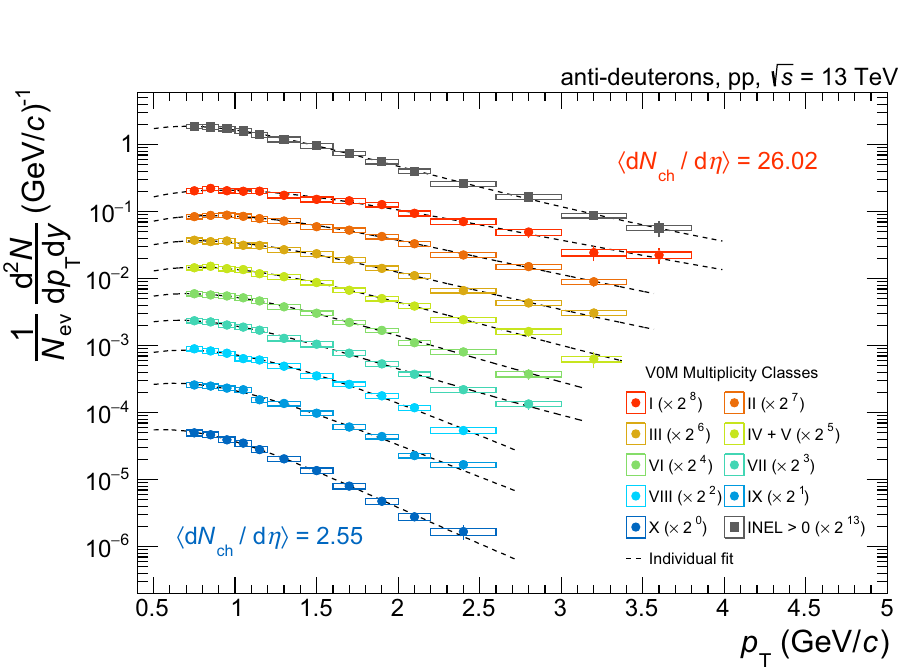
Fig. 1 Transverse-momentum spectra of deuterons (top) and anti-deuterons (bottom) measured in pp collisions at √ s = 13 TeV in different multiplicity classes (circles) and in INEL > 0 events (squares). The mean charged-particle multiplicity for classes I and X are reported in the figures and all the values for the multiplicity classes can be found in Table 1. For the analyses in multiplicity classes, the multiplicity increases moving from the bottom of the figure upwards. The statistical uncertainties are represented by vertical bars while the systematic uncertainties are represented by boxes. The dashed lines are individual fits with a Lévy–Tsallis function [27]